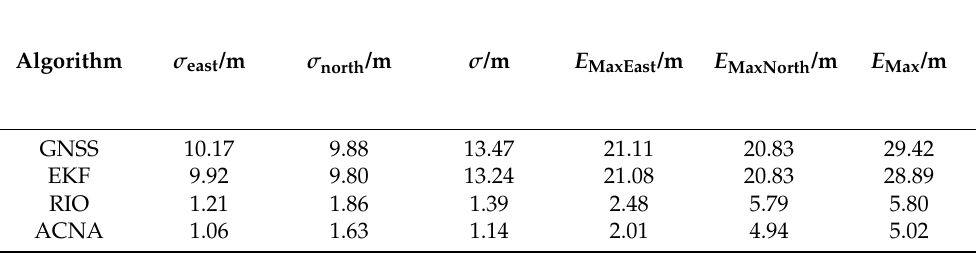
Figure 14. The trajectories of the three algorithms on data set (cid:101) Ψ 2 : ( a ) EKF; ( b ) RIO; ( c ) ACNA. Table 3. East, north and relative positioning accuracy and maximum error of the three algorithms on data set (cid:101) Ψ 2